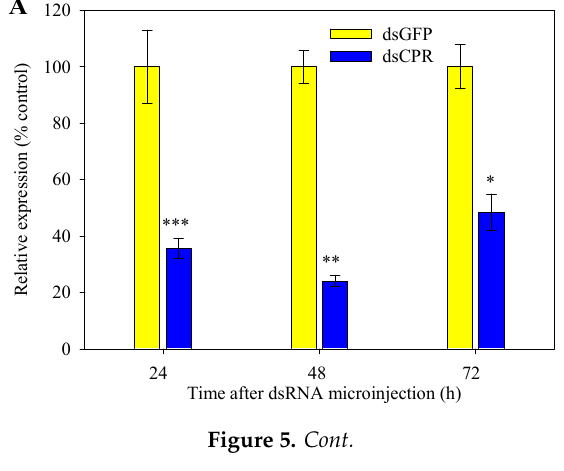
above bars indicate significant differences ( p < 0.05) according to Duncan’s multiple range test.